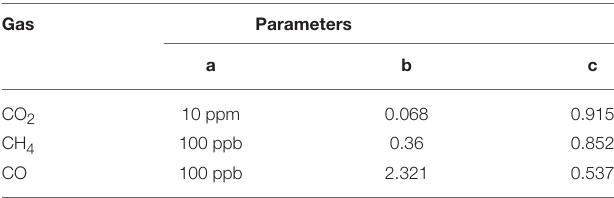
TABLE 1 | Constants for uncertainty parameterization as a function of SNR as in O’Brien et al. (2016). Gas